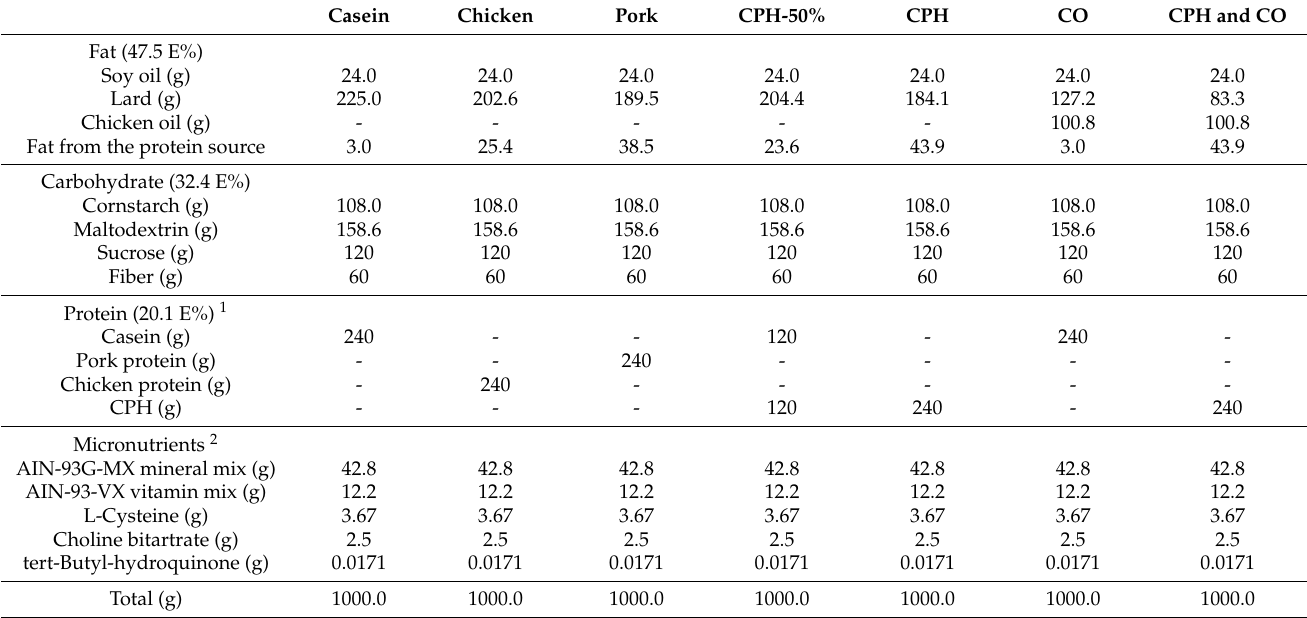
Table 1. Nutrient composition in the diets calculated without